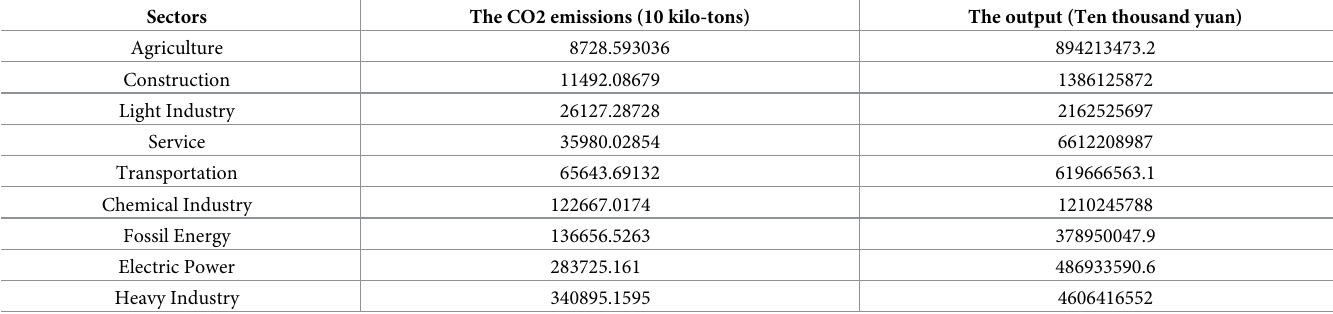
Table 6. The carbon emissions and output from the 9 sectors. Sectors The CO2 emissions (10